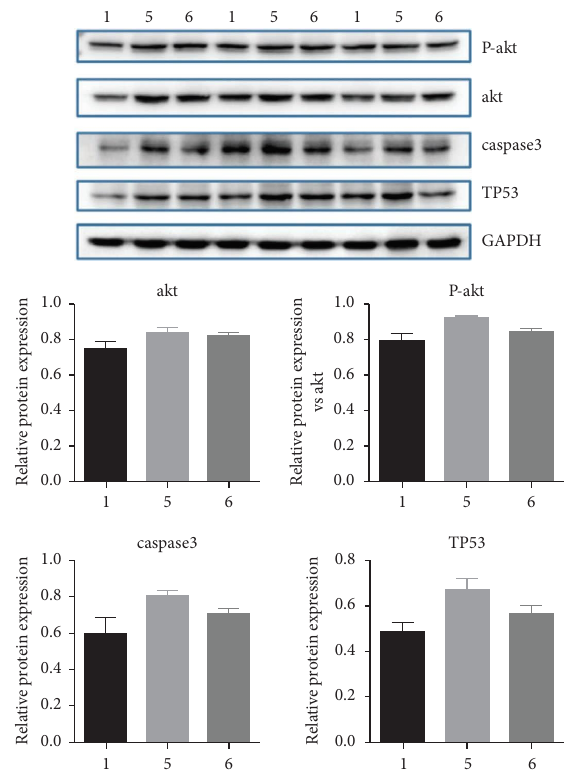
Figure 10: Western blot assay of phosphorylated Akt, Akt, CASP3, and TP53. From left to right, the SLC concentrations were 0, 2, and 4g/L. Caspase3 and TP53 of HGC-27 cells were overexpressed after treated with SLC